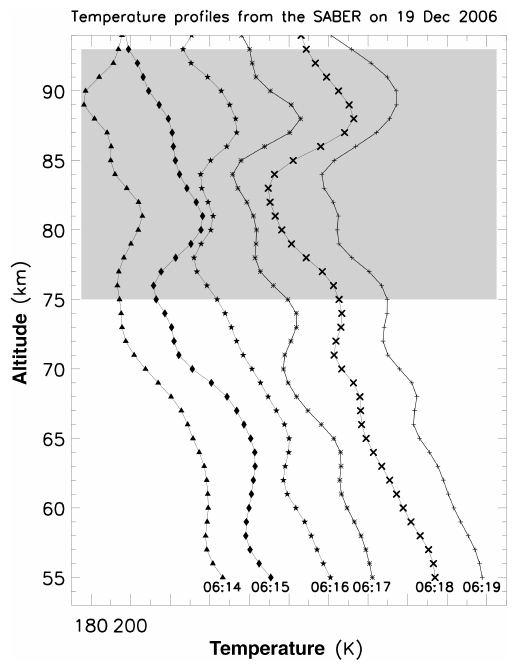
Figure 3. The six temperature profiles corresponding to the SABER soundings shown in Fig.